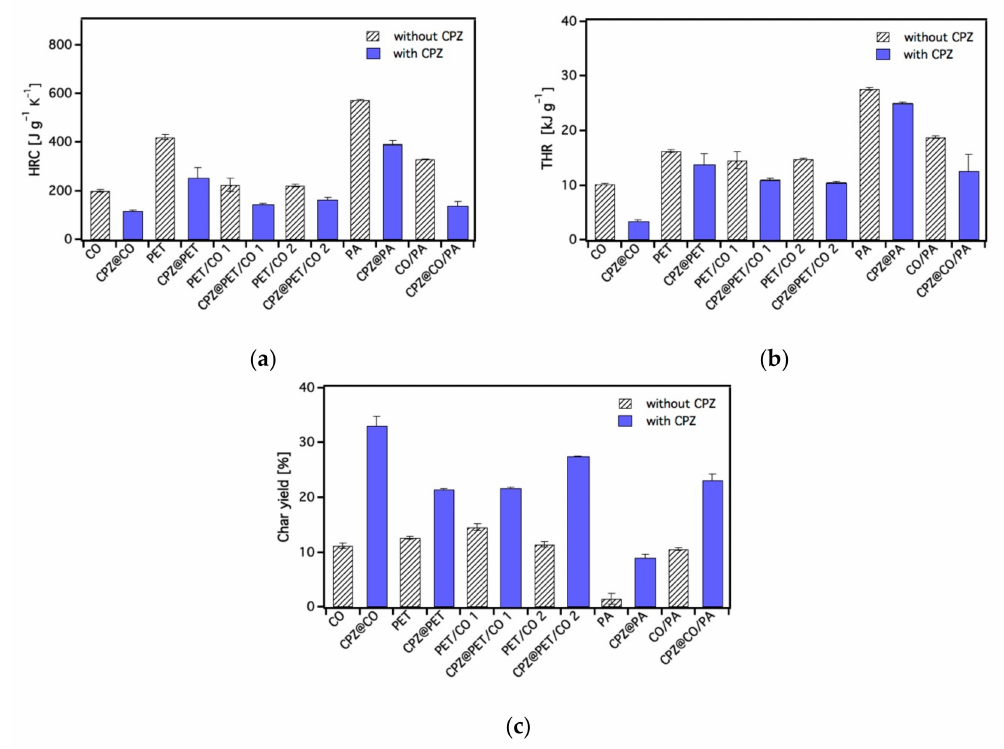
Figure 6. Overview of the MCC key parameters. ( a ) HRC: heat release capacity; ( b ) THR: total heat release, and ( c ) char yield obtained after MCC measurements. The add-on value for all samples is around 10